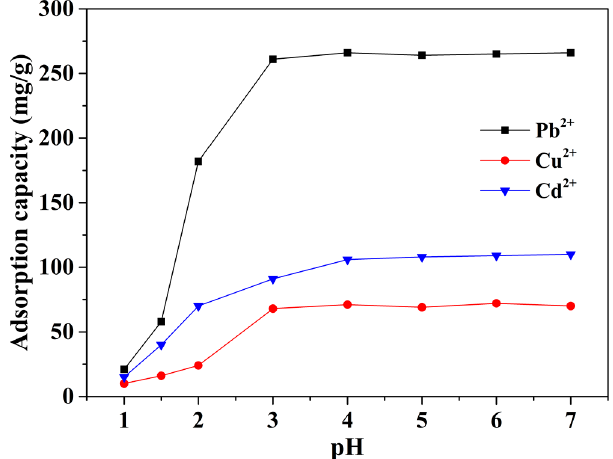
Figure 4. Effect of pH on metal ions adsorption. (~50 mg of mp-CA/GO was equilibrated with 50 mL of 1.5 mM Pb 2+ , Cu 2+ , or Cd 2+ at 25 °C for 40 min).